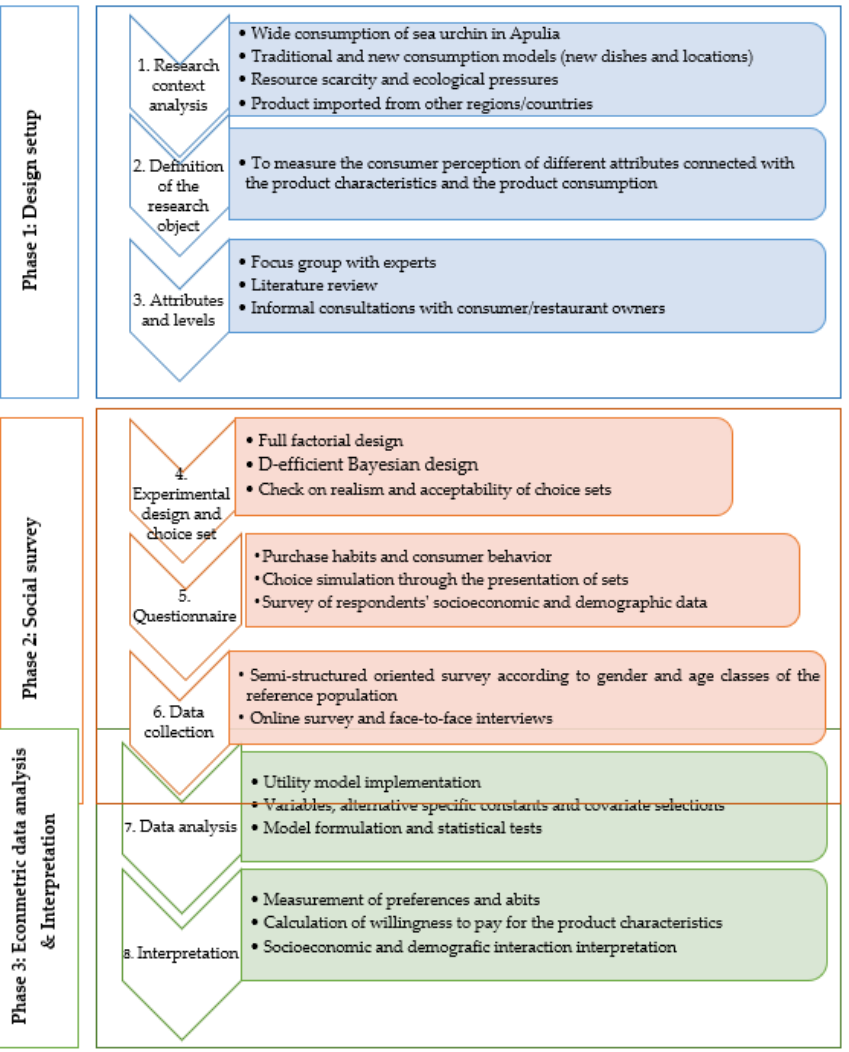
Figure 3. Overview of the discrete choice experiment (DCE) approach. The diagram highlights the steps in each phase of the DCE that were considered in our study, in which steps 1 and 2 have already been described in Section 1.